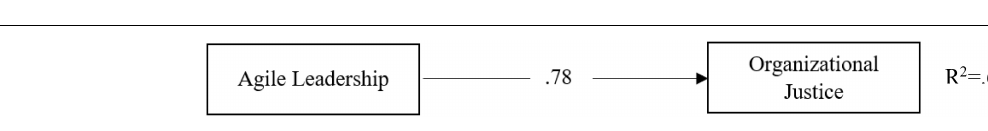
FIGURE 2 | The relationship between agile leadership and job satisfaction.